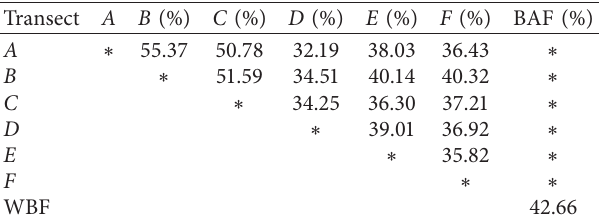
Table 3: Jaccard similarity index of plant species in west bank and block A forest of IITA.